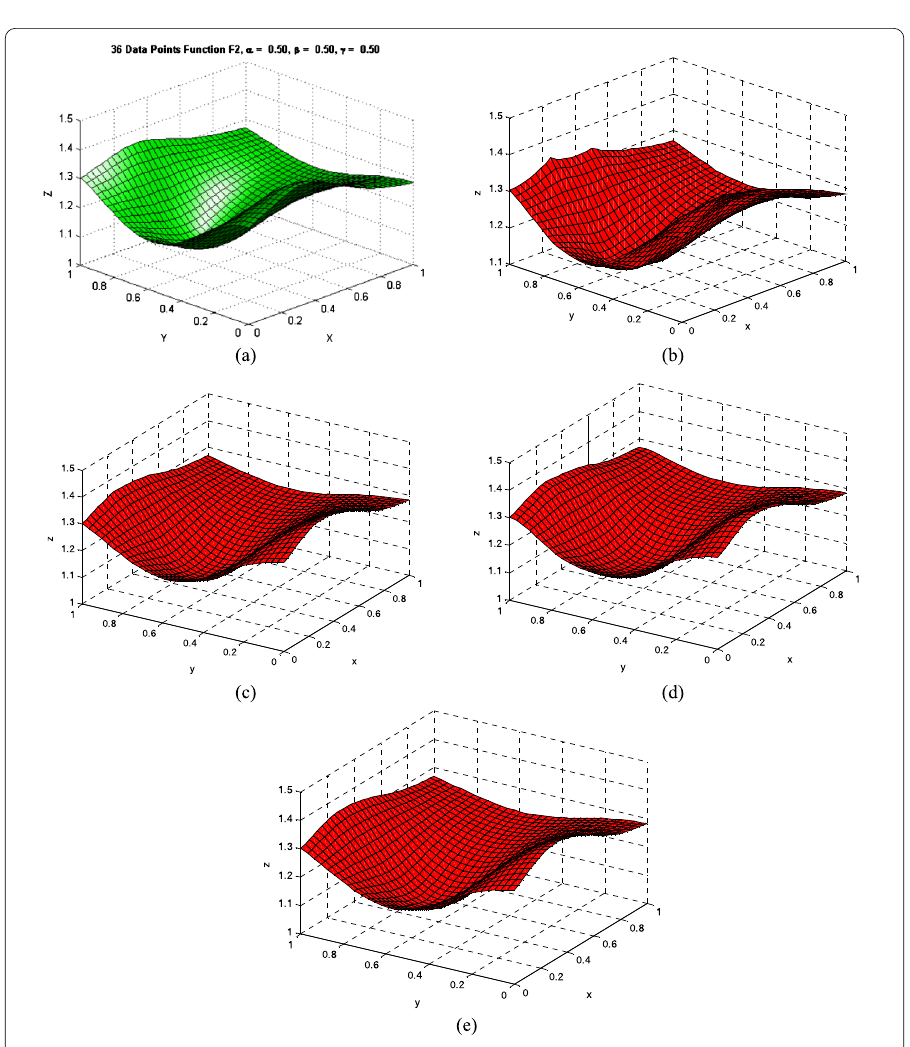
Figure 9 Surface interpolation for 36 data points for the test function F 2 : ( a ) The proposed method; ( b ) RBF (linear); ( c ) RBF (thin plate spline); ( d ) RBF (Gaussian); ( e ) RBF